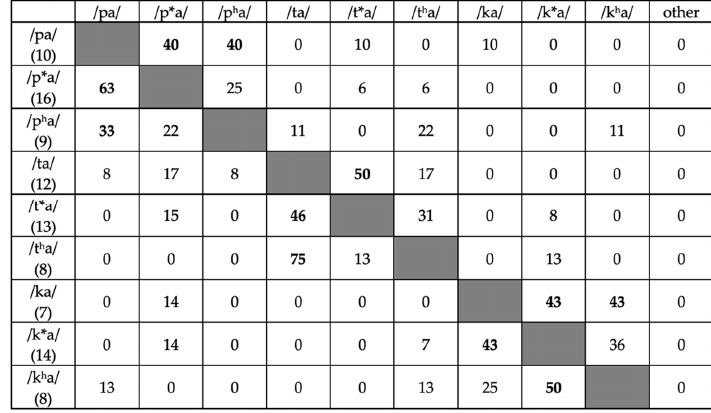
Figure A4. Confusion matrix of errors by the no ‐ contrast group in the posttest for vowel items (vertical = stimuli, horizontal = responses). Each cell shows the percent of all errors on the given stimulus represented by the given response (rows may not add to 100% due to rounding); the most common error type for each stimulus is bolded. The total number of errors for each stimulus (across all participants in the group) is shown in parentheses.